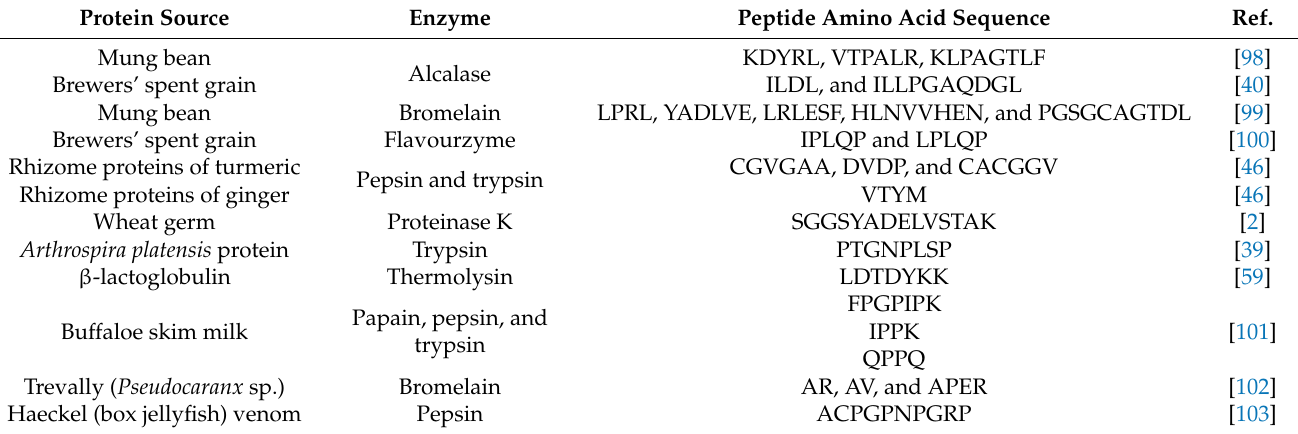
Table 2. Antihypertensive activity of bioactive peptides obtained from different protein